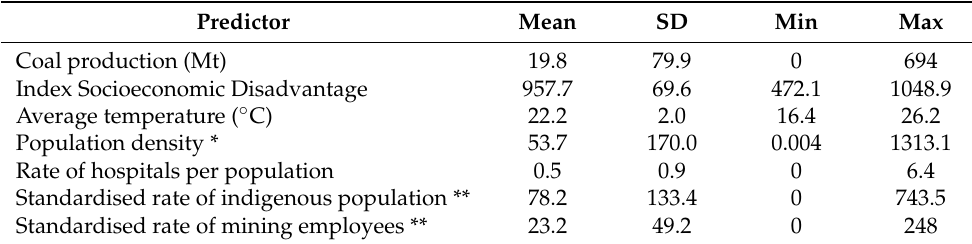
Table 2. Descriptive summary statistics of the